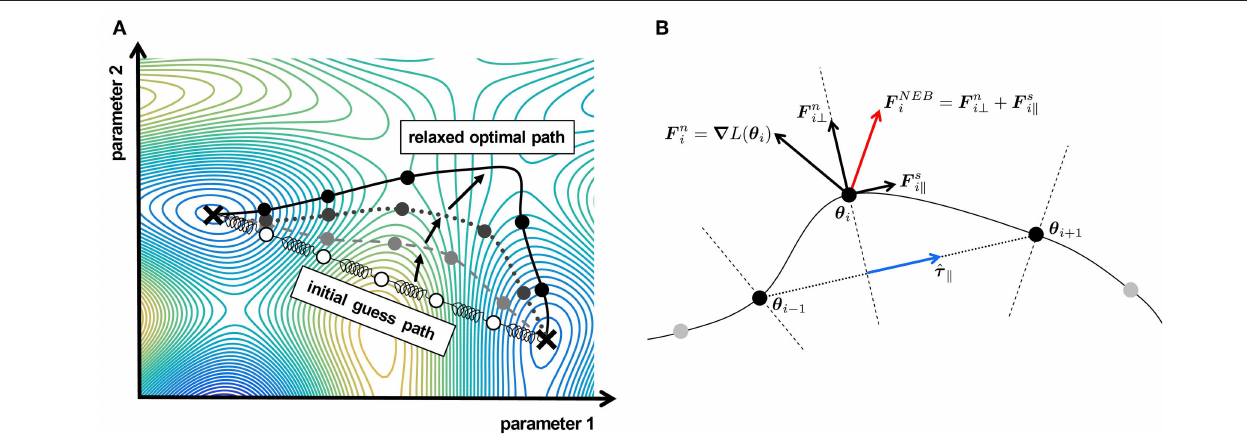
FIGURE 1 | Spring methods for path finding. (A) An elastic band with initial nodes (white dots) connected by springs is relaxed in an illustrative likelihood landscape. The dashed light gray band illustrates an intermediate step during relaxation according to the forces in Equation (8). The dark gray band with the dotted line depicts the state of equilibrating forces for a large spring constant k , which does not completely converge to the minimal, i.e., optimal path. The black solid line and circles represent the final state of a band with adequately small spring constant k and coincides with the optimal path. (B) Nudged Elastic Band (NEB) with forces according to Equations (9) and (10). The blue arrow represents the tangent along the path of the i -th node, characterizing the hyperplane (dashed line) on which the node is